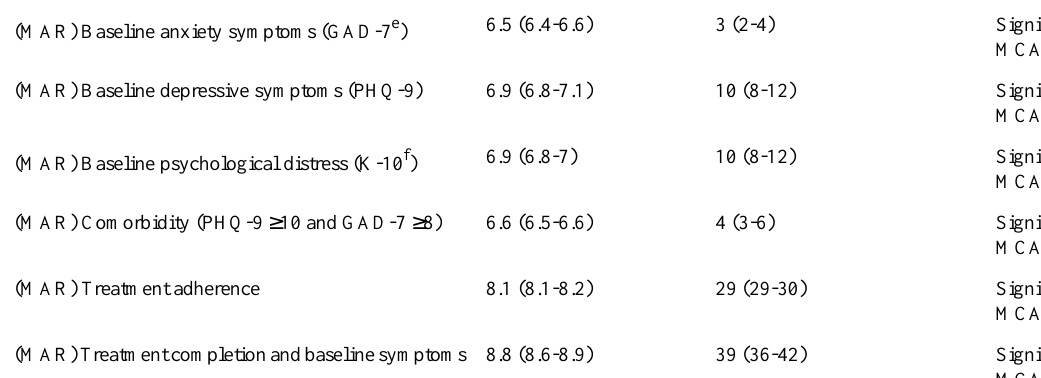
Models adjusted for predictors that form nonignorable missing cases mechanisms (missingness and PHQ-9 d outcome moderators)